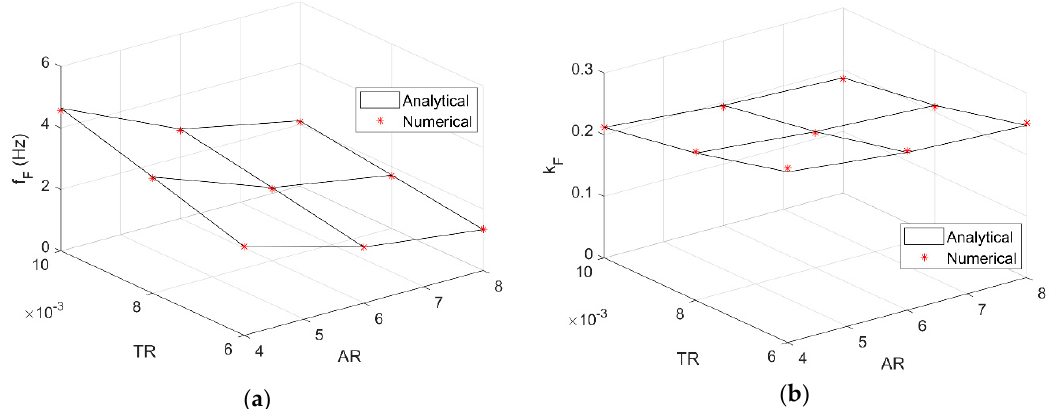
Figure 8. Flutter frequency ( a ) and reduced frequency ( b ) speeds according to SST.